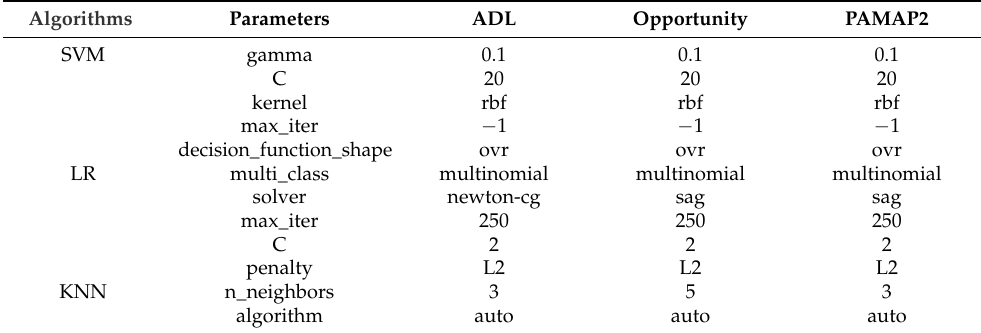
Table A1. Parammeters settting of SVM, LR and KNN on multiple dataset. Ref. [47] provides description about the parameters that we